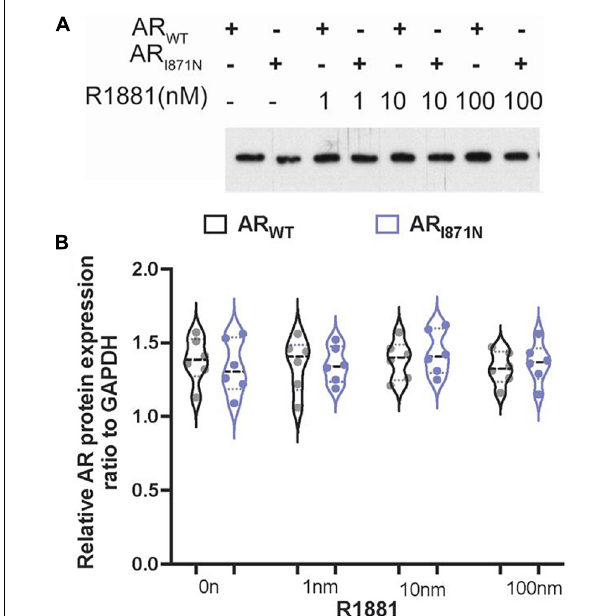
FIGURE 1 | The protein expression of AR WT and AR I871N in transfected cells. (A) The expression levels of AR WT and AR I871N were analyzed in cells 24 h post-transfection in the presence of R1881 (1, 10, and 100 nM) or vehicle alone (0.1% DMSO). An amount of 10 ug lysate was subjected to SDS-PAGE and immunoblotting with AR monoclonal antibody. No significant differences of expression were found between AR WT and AR I871N . (B) Quantitation the protein expression levels of AR.